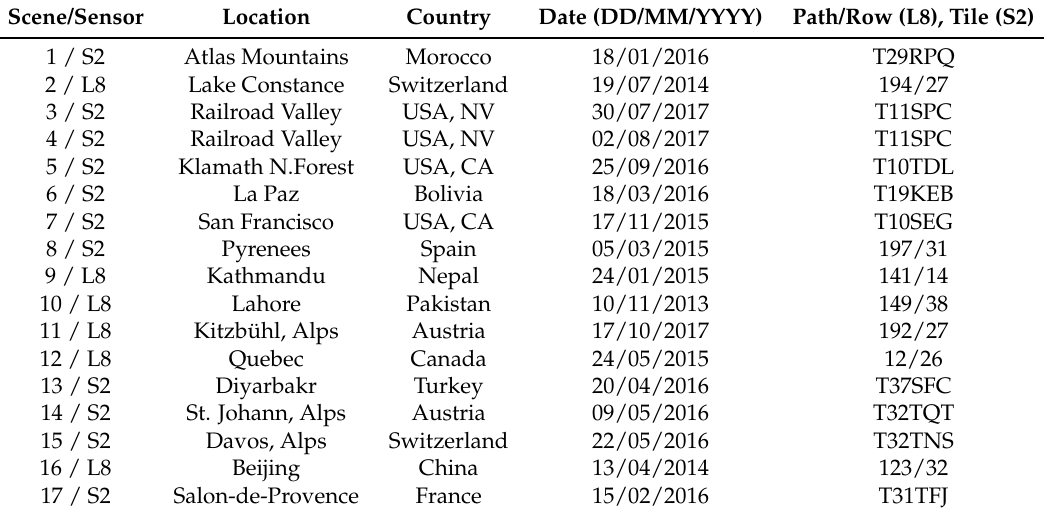
Table A1. Landsat-8 level L1T and Sentinel-2 level L1C test